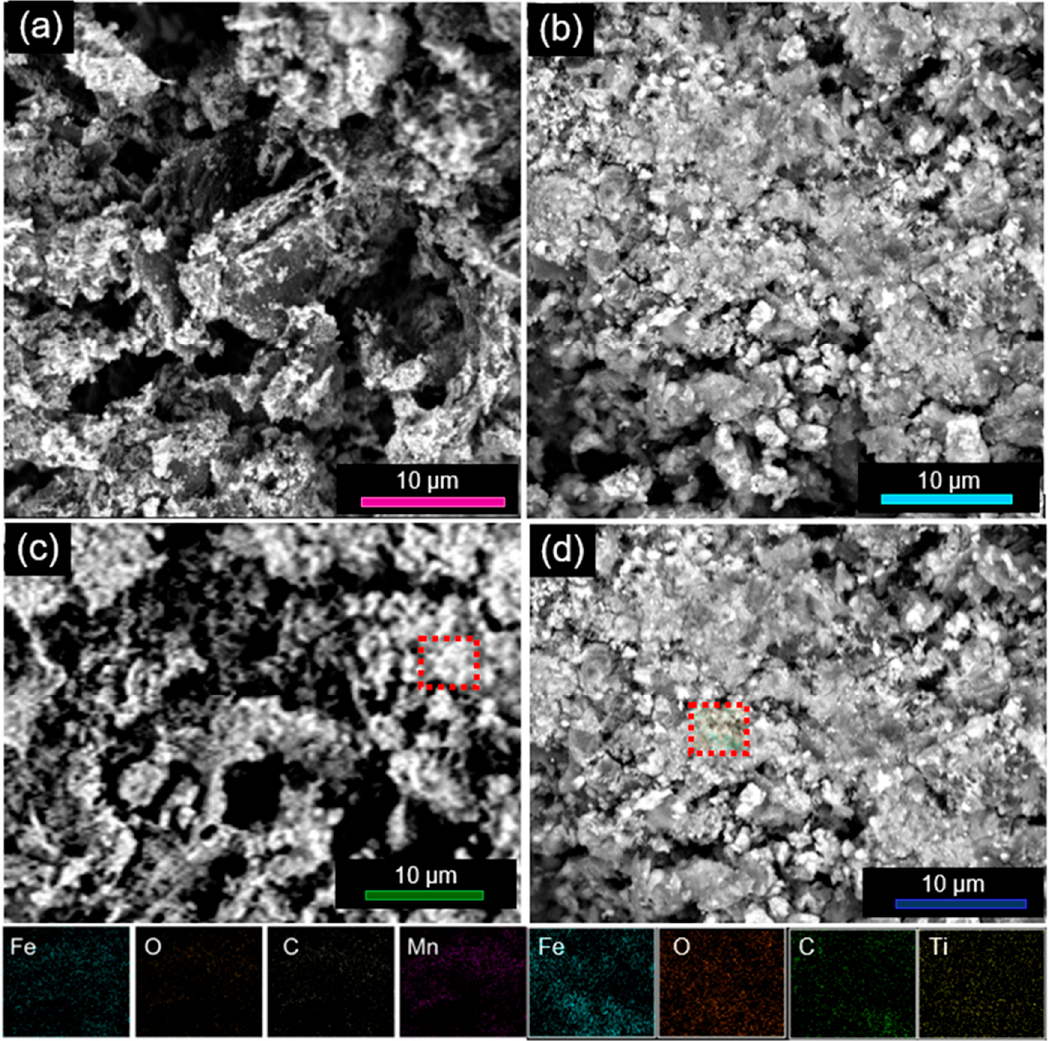
Figure 1. ( a–d ) Morphology and ( c,d ) elemental composition nanocomposites. The shown SEM images refer to samples ( a ) α -Fe 2 O 3 @rGO-50, ( b ) α -Fe 2 O 3 :Ti@rGO-50, ( c ) α -Fe 2 O 3 :Mn@rGO-30 and ( d ) α -Fe 2 O 3 :Ti@rGO-30; the elemental maps refer to the region marked by a red dashed rectangle of samples ( c ) α -Fe 2 O 3 :Mn@rGO-30 and ( d ) α -Fe 2 O 3